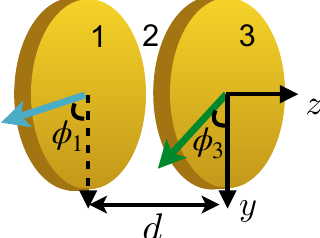
Figure 1. A pair of flat, coplanar topological insulator slabs (labeled 1 and 3) separated by a vacuum gap (labeled 2) of width d . The optic axis of slab 1 (3) is colored cyan (green), and the orientations of the optic axes measured with respect to a reference axis (in this case the y axis) are φ 1 and φ 3 . In the figure, we only show a finite slice of the slabs, which are assumed to have infinitely large thicknesses and cross-sectional areas. Figure adapted from Ref.